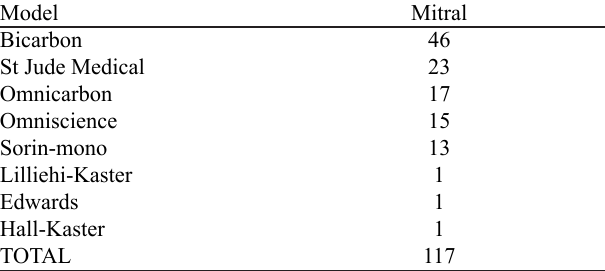
Chart 1. Models of mechanical heart valve prostheses